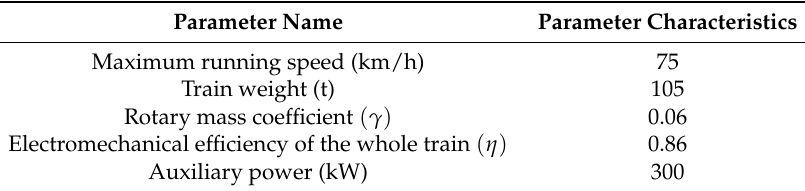
Figure 14. The speed limit curve and ramp value curve. Table 2. The properties of the train.